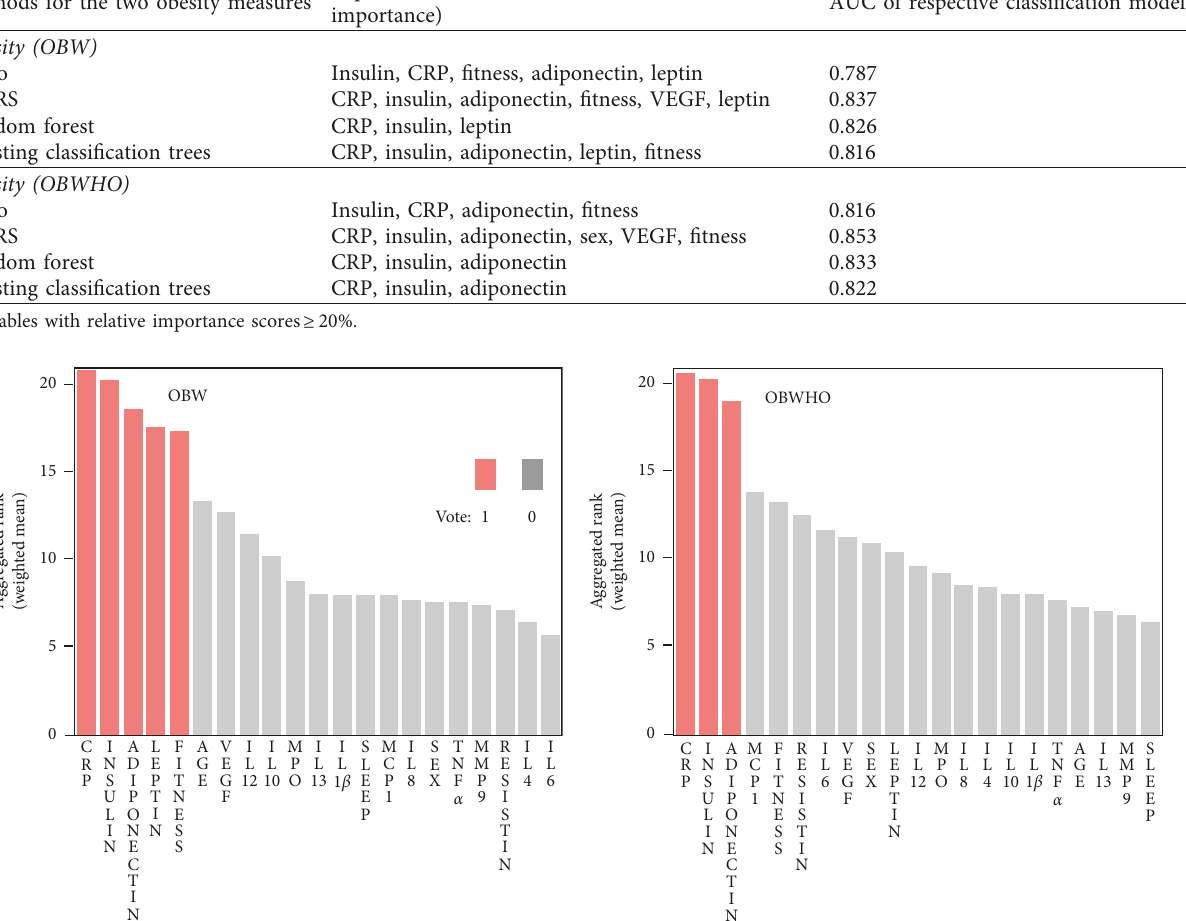
Table 1: Important variables associated with OBW and OBWHO as identified by three algorithms. Top-ranked variables ∗ (in the order of relative Methods for the two obesity measures importance)